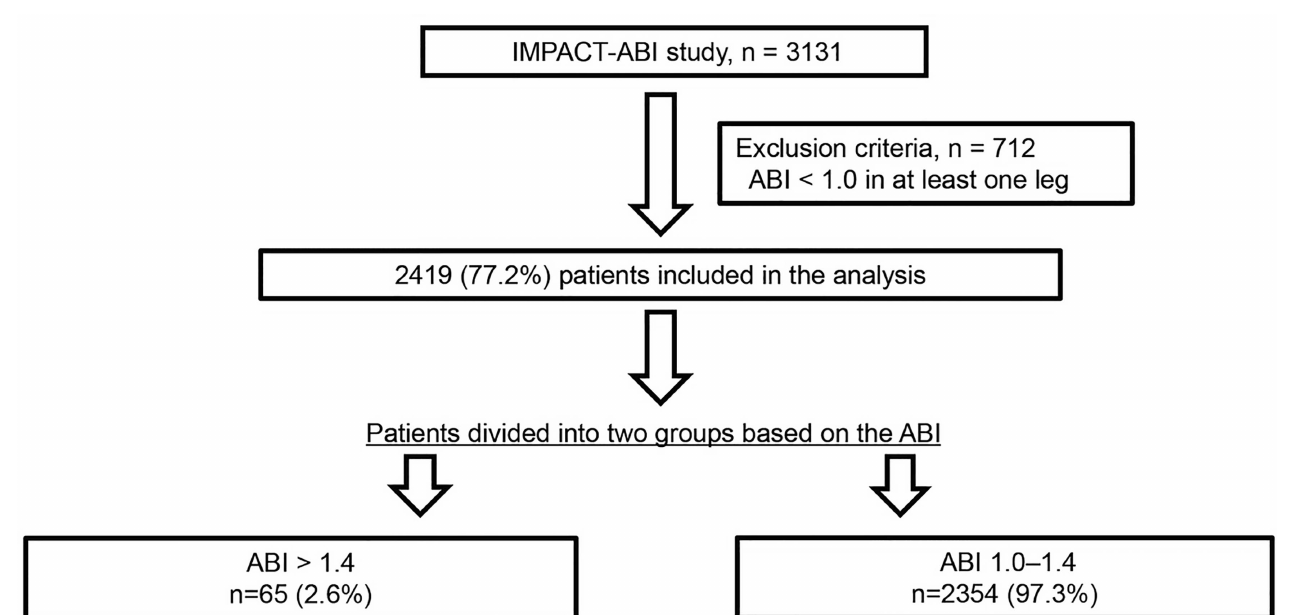
Fig 1. Study flow diagram illustrating the inclusion process and exclusion criteria. Patients were stratified into two groupsbased on their ankle-brachial index (ABI)